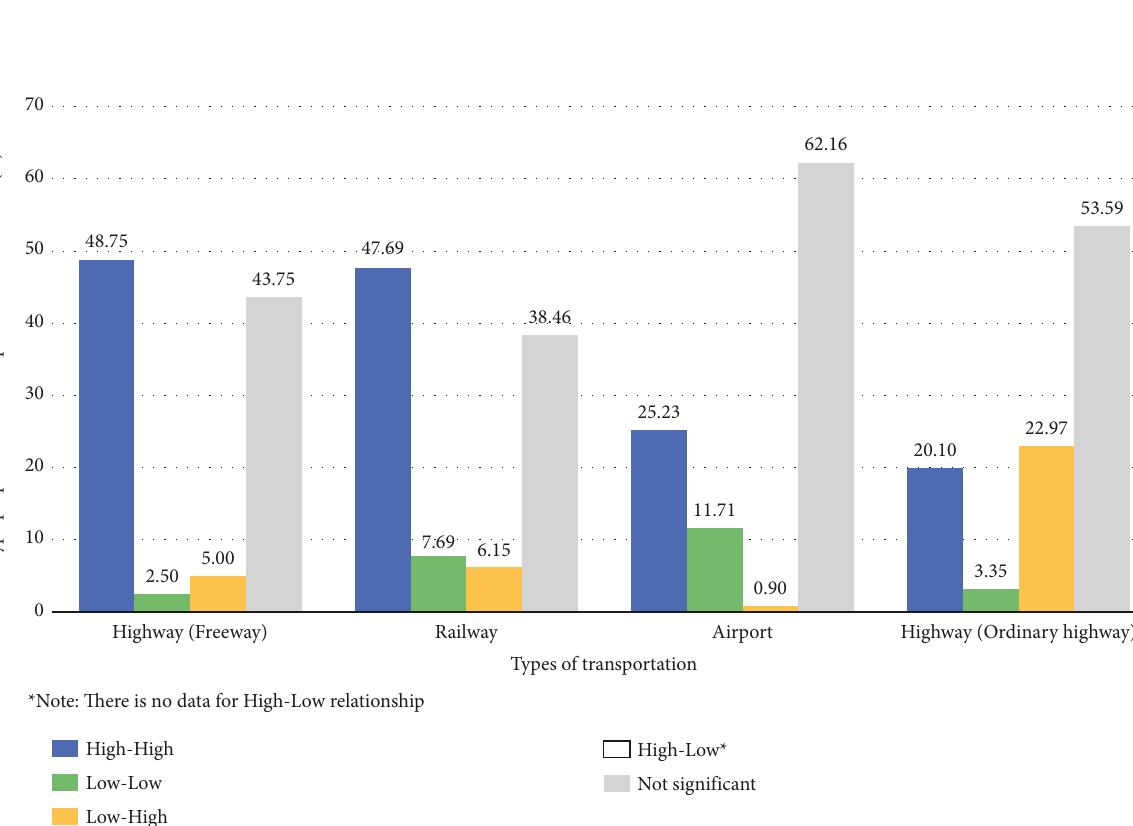
Figure 11: Local spatial autocorrelation of TIID .